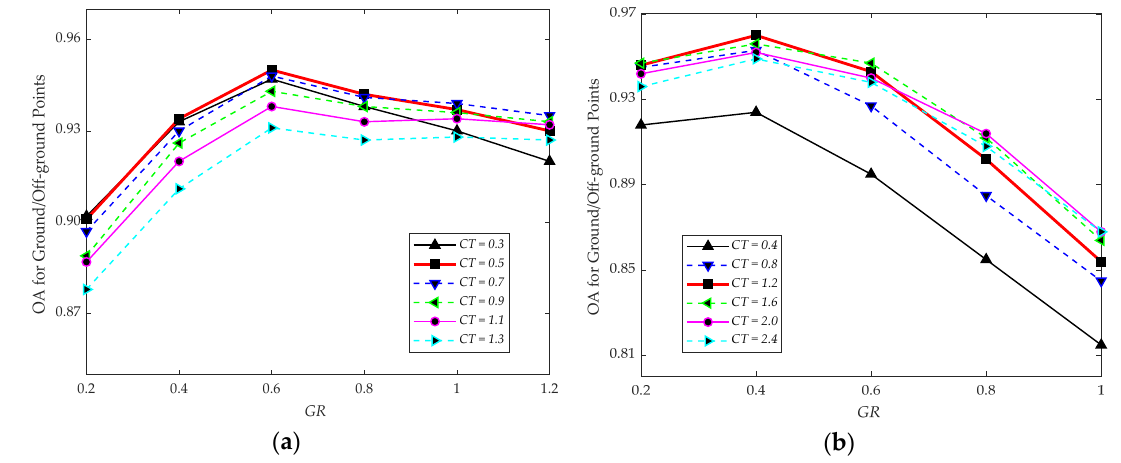
Figure 13. ( a ) Parameters analysis of CSF algorithm for Vaihingen Dataset; ( b ) Parameters analysis of CSF algorithm for GML Dataset A.